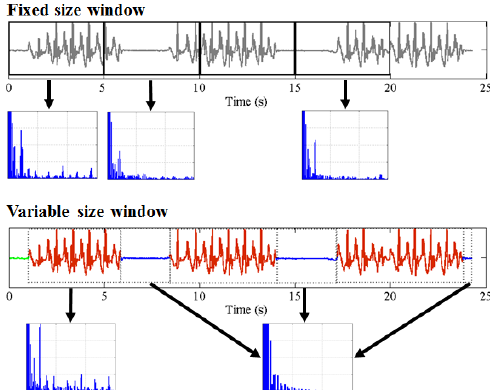
Figure 6. Demonstration of how the traditional feature extraction approach relying on windowing with fixed window size can lead to misleading estimates of any features from the frequency domain. The bottom plot demonstrates how an accelerometer signal is segmented using a switching AR model, and more accurate estimates of frequency domain features can be obtained as a result. We observe this by looking at how the power spectra